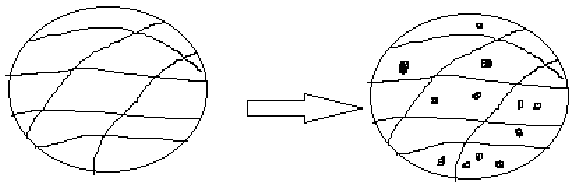
Figure 7. Schematic diagram of a hydrogel.